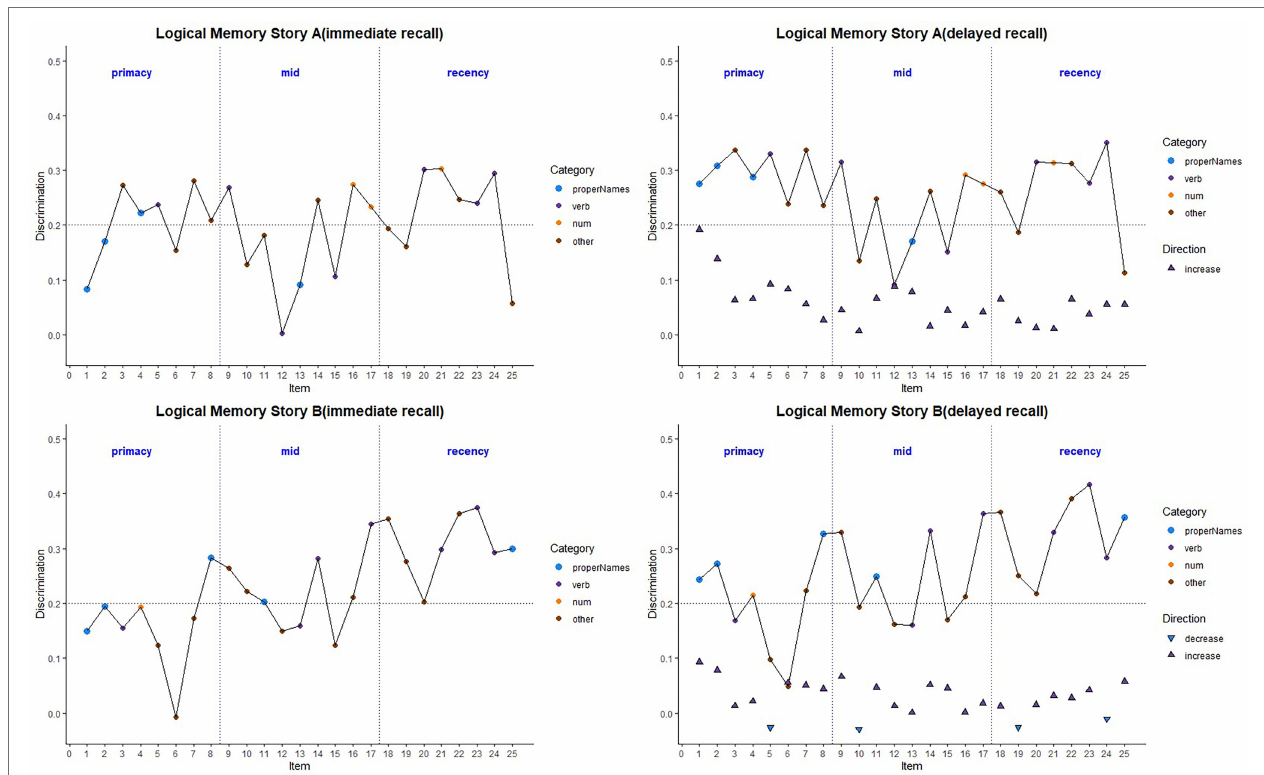
FIGURE 4 | Item discrimination plots (averaged across visits) according to the serial position (primacy, mid, and recency) as well as the lexical category of the items, by story A and story B. Higher discrimination values = better discrimination. Across the primacy, mid and recency positions, proper name recall shows an increase in discrimination for both story A and story B. The triangles are the mean difference between recall condition for story A and story B. The horizontal dashed lines are desirable discrimination values (>0.2). Supplementary Figure S2 shows item discrimination by visit, revealing a consistent pattern across all study